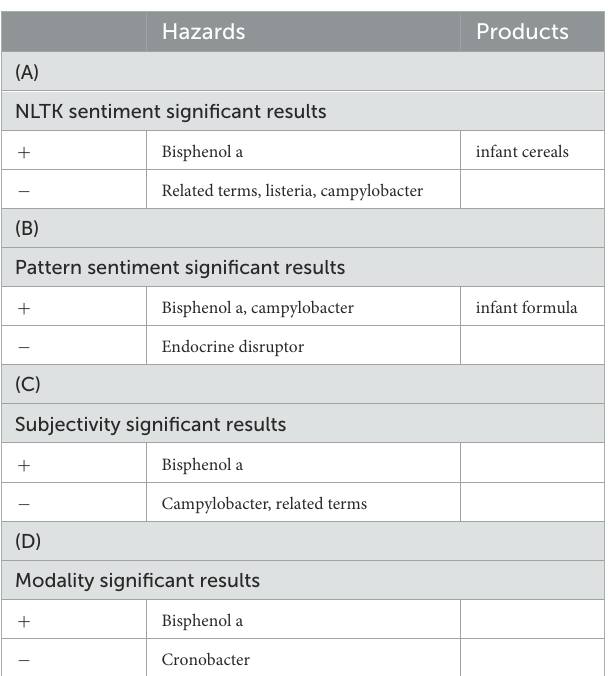
TABLE 1 Regression result